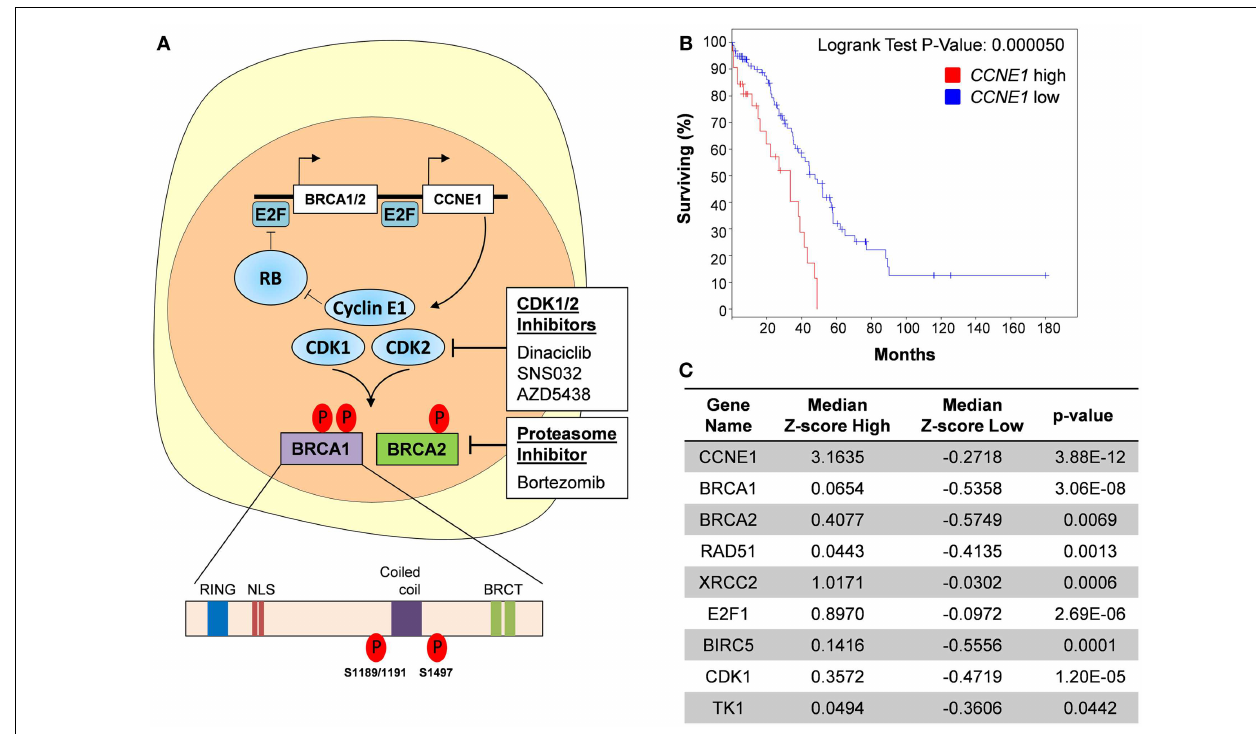
tumors, Z -score < 2). Median OS for cancers with CCNE1 high and normal/low expression were 33.44 and 47.47months, respectively. A subset of 129 HGSOC tumors from theTCGA dataset was used for this analysis and was selected based on p53-mutant and BRCA1- and BRCA2- wildtype status as well as availability of RNAseqV2 data. Data were accessed using the cBioPortal for Cancer Genomics maintained